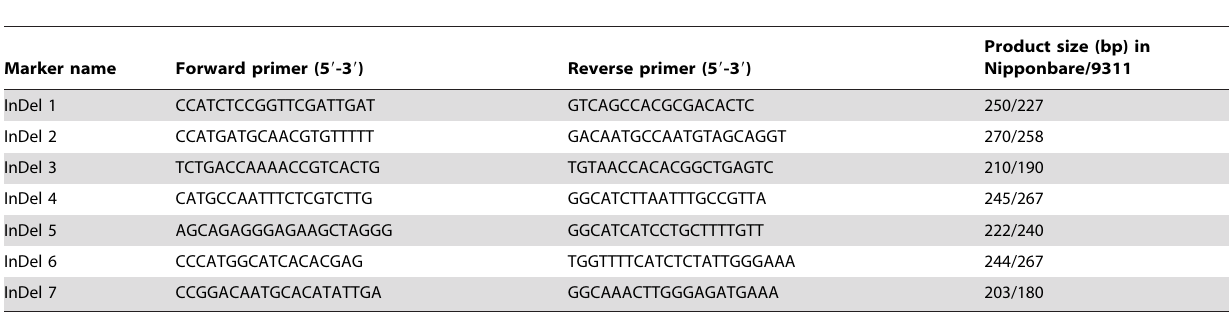
Table 1. Primer sequence of InDel markers developed for fine mapping of sbe3-rs flanked by RM13313 and RM8254.